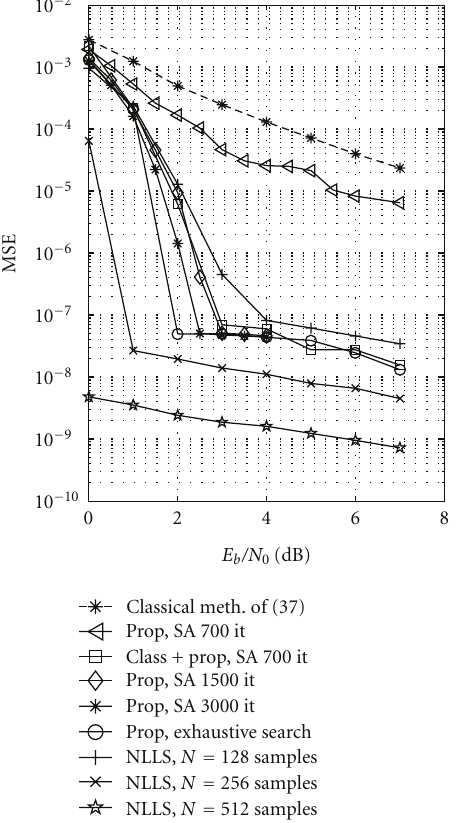
Figure 8: MSE of the carrier frequency o ff set estimation for a BPSK modulation.